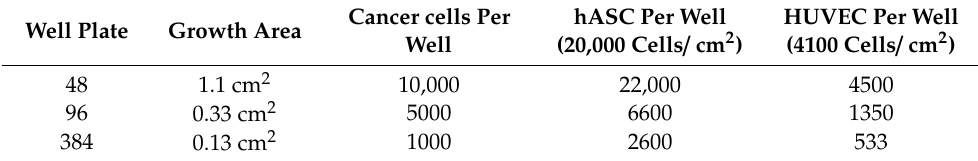
Table 4. Number of seeded cells for di ff erent well plate